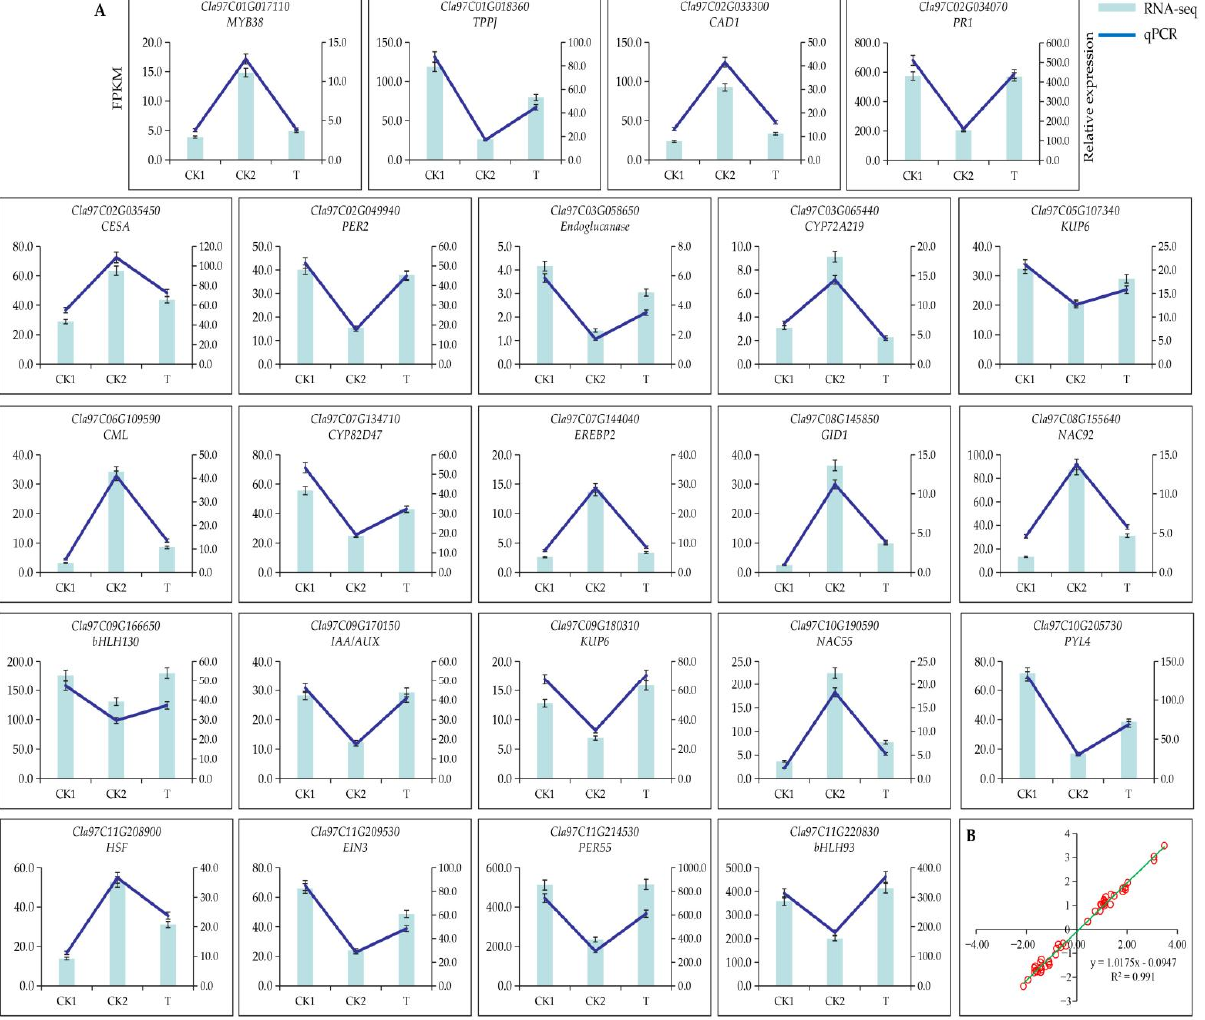
Figure 3. Transcriptomic data were validated using qPCR. ( A ) Gene expression patterns of RNA ‐ seq and qPCR. ( B ) The consistency of RNA ‐ seq and qPCR data was demonstrated based on scatter plot. X axis represents log 2 (CK2/CK1) and log 2 (T/CK2) of RNA ‐ seq, Y axis represents log 2 (CK2/CK1) and log 2 (T/CK2) of qPCR.